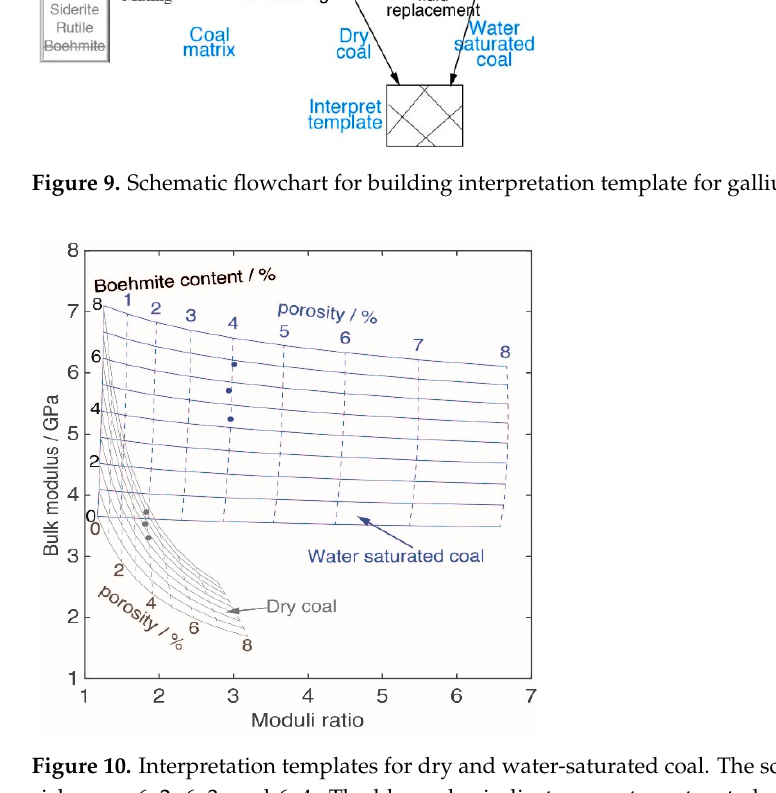
Figure 10. Interpretation templates for dry and water-saturated coal. The scatter points are gallium- rich cores 6–2, 6–3, and 6–4. The blue color indicates a water-saturated state, and the gray color indicates a dry state.